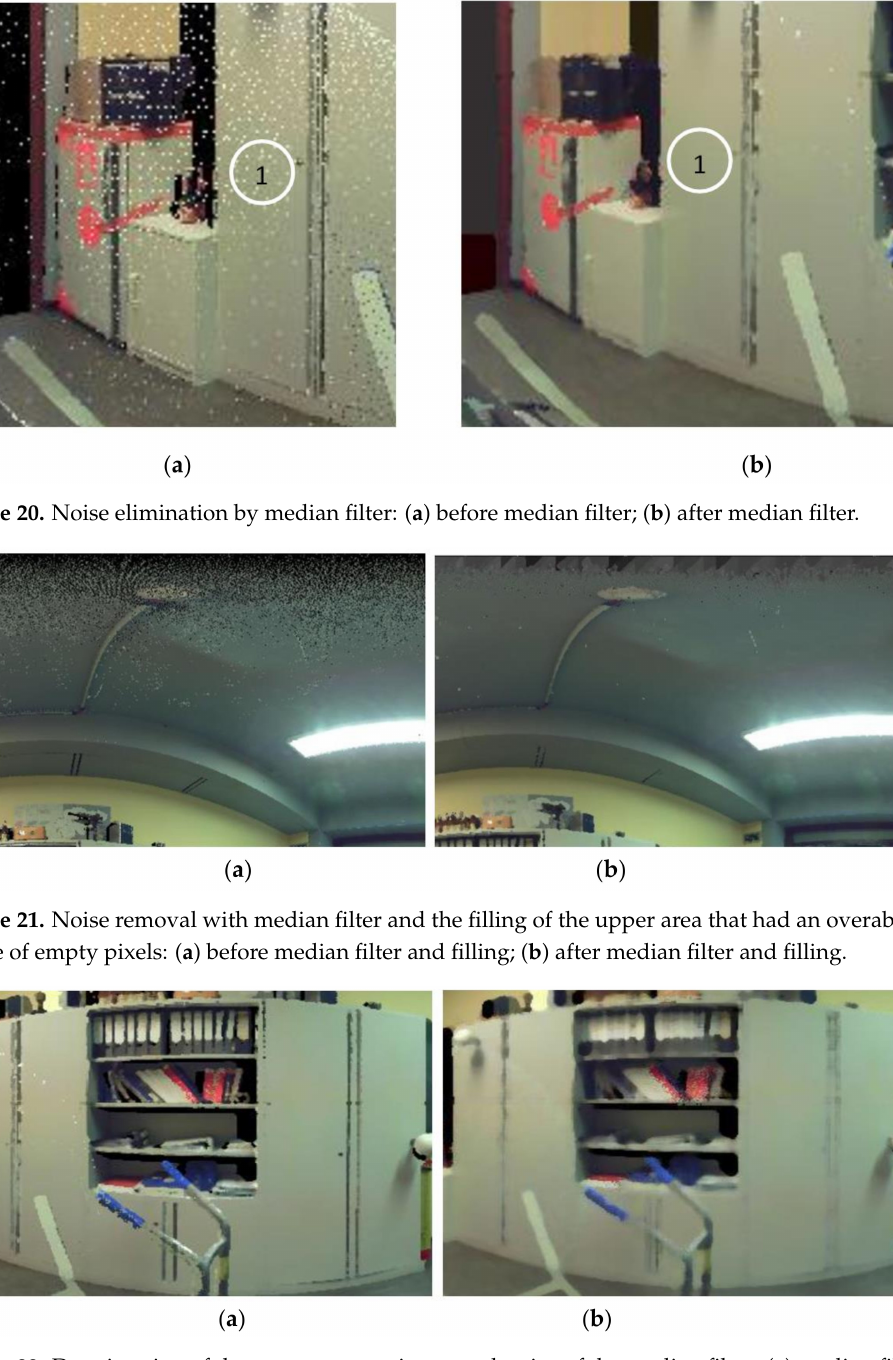
Figure 22. Deterioration of the contrast as we increase the size of the median filter: ( a ) median filter 3 × 3; ( b ) median filter 7 ×